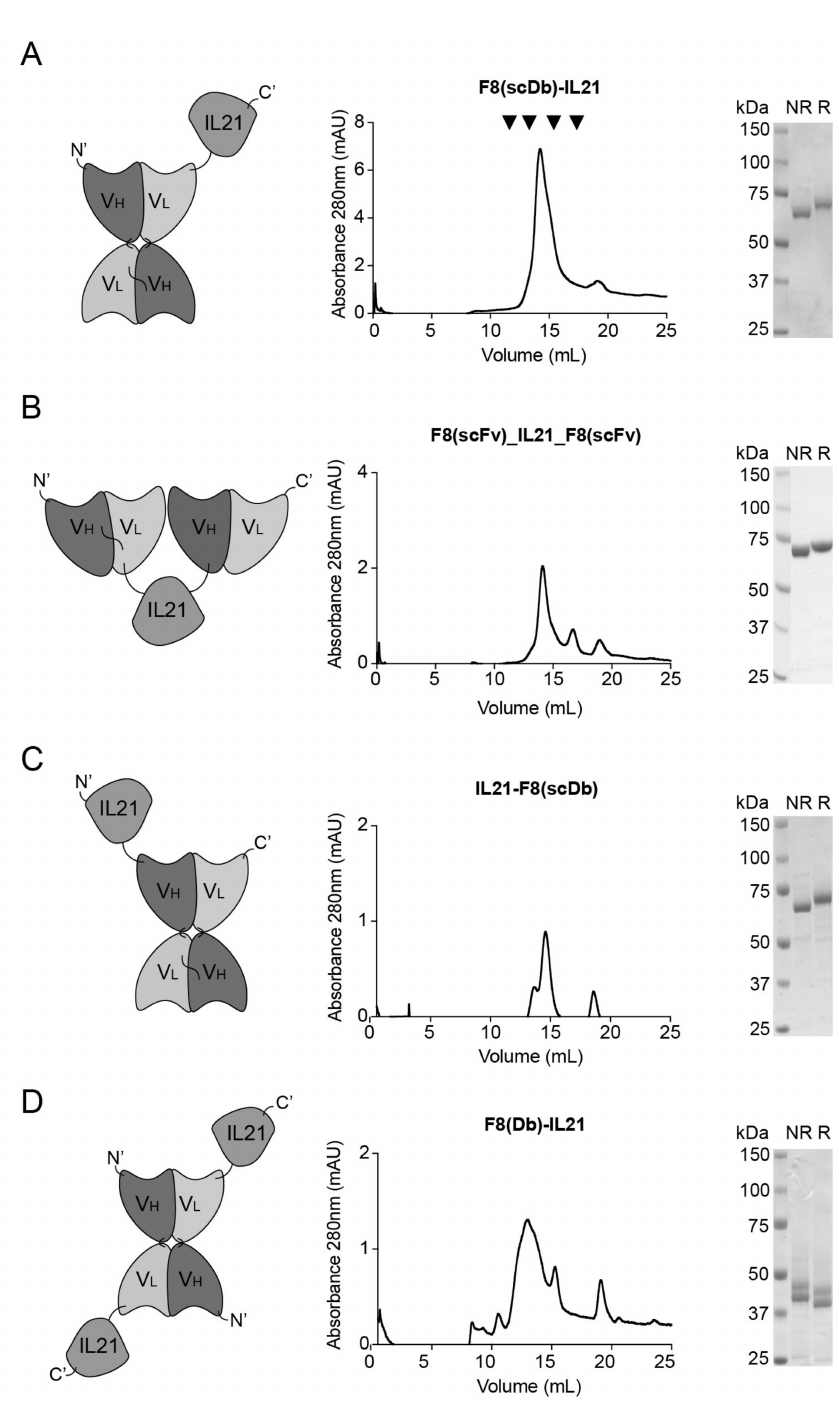
Figure 1. In vitro characterization of hIL21-fusion proteins. ( A ) F8(scDb)-IL21 ( B ) F8(scFv)-IL21- F8(scFv) ( C ) IL21-F8(scDb) and ( D ) F8(Db)-IL21. From left to right: schematic drawing of the antibody fusion protein; SEC profile and SDS-PAGE (NR, non-reducing condition; R, reducing condition, for the final figures gels were cut and put together). Standard references for superdex 200 increase 10/300 GL column are indicated by black arrows in A (from left to right): IgG1 146 kDa elution volume at 12 mL; Conalbumin 75 kDa elution volume at 14 mL; Ovalbumin 44 kDa elution volume at 15 mL; Carbonic anhydrase 29 kDa elution volume 16.5